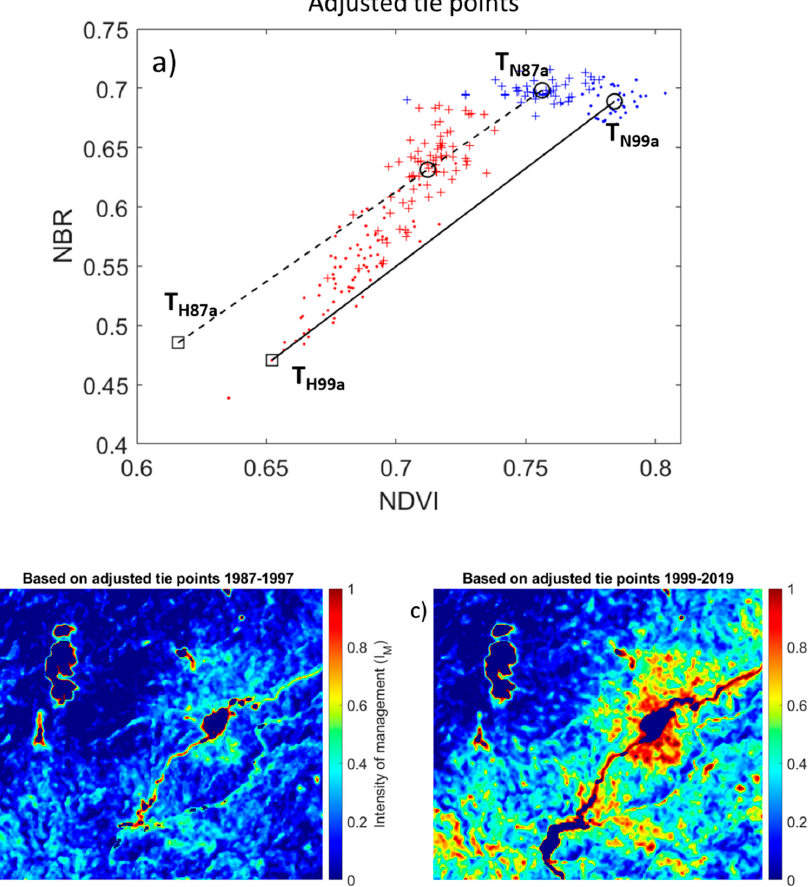
Figure 11. ( a ) Mean tie-points for NF (T N ) and HMCF ( T H ), and the intensity of management ( I m ) estimated using the tie-points for ( b ) the 1987–1997 and ( c ) 1999–2019 periods. In (a), for the 1987– 1997 period, the data points for NF and HMCF sites are shown in small blue and red crosses and in a dotted line connecting the tie-points T N87 and T H87 . For the 1999–2019 period, the data points for NF and HMCF sites are shown in blue and red dots and in a solid line connecting the tie-points T N99 and T H99 .